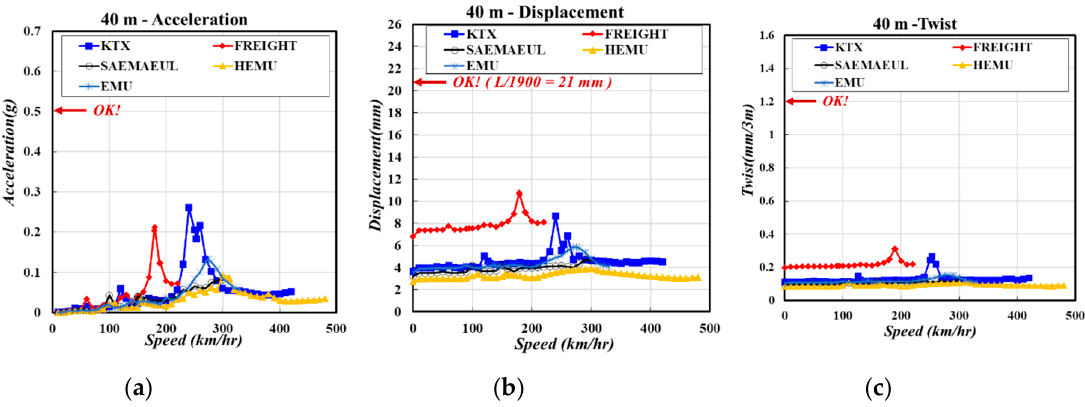
Figure 12. Moving load analysis results for span length of 40 m: ( a ) vertical acceleration response; ( b ) vertical displacement response; and ( c ) twist response.